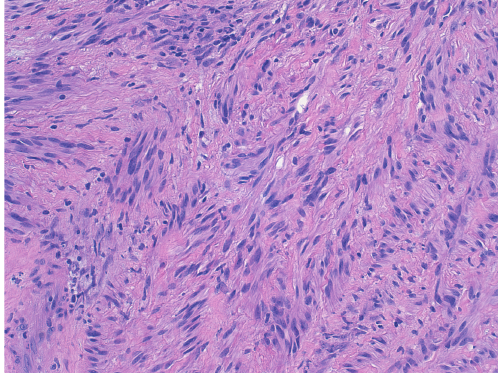
Figure 4: Histology of the esophageal mass upon resection. Micro- scopic examination of the esophageal mass revealed palisading spindled cells with dense chromatin, rare mitoses and scattered atypia (H&E, x100). Immunohistochemistry revealed the tumor to be positive for the S100 protein (not shown), confirming nerve sheath